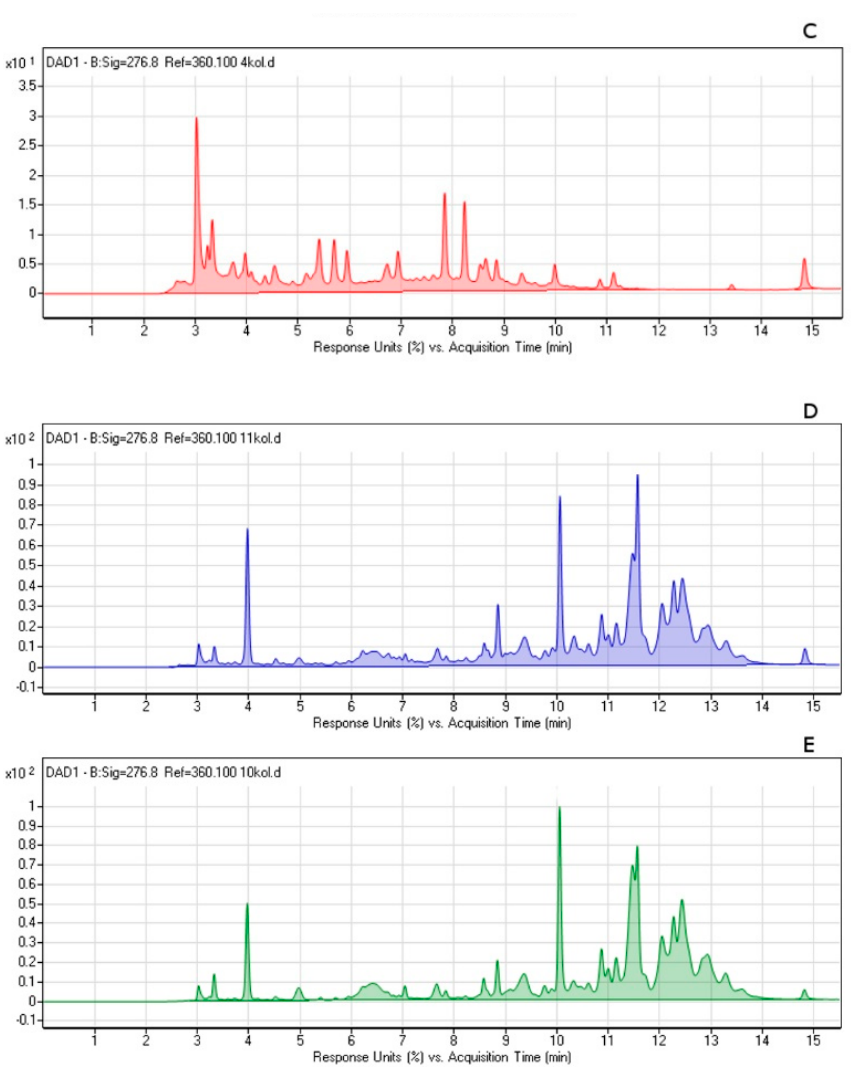
Figure 4. Chromatograms HPLC-DAD for samples of gall nuts C. quercusfolii from three forest habitat types (( A ) moist mixed broadleaved forest, ( B ) fresh broadleaved forest, ( C ) moist broadleaved forest) and gall nuts A. infectorius (( D ) first harvest date, ( E ) second harvest date).